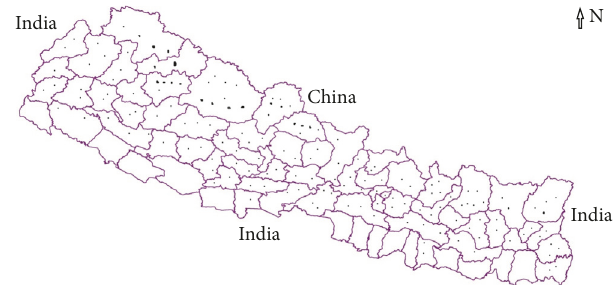
Figure 1: Distribution of cultivated buckwheat in districts of Nepal.